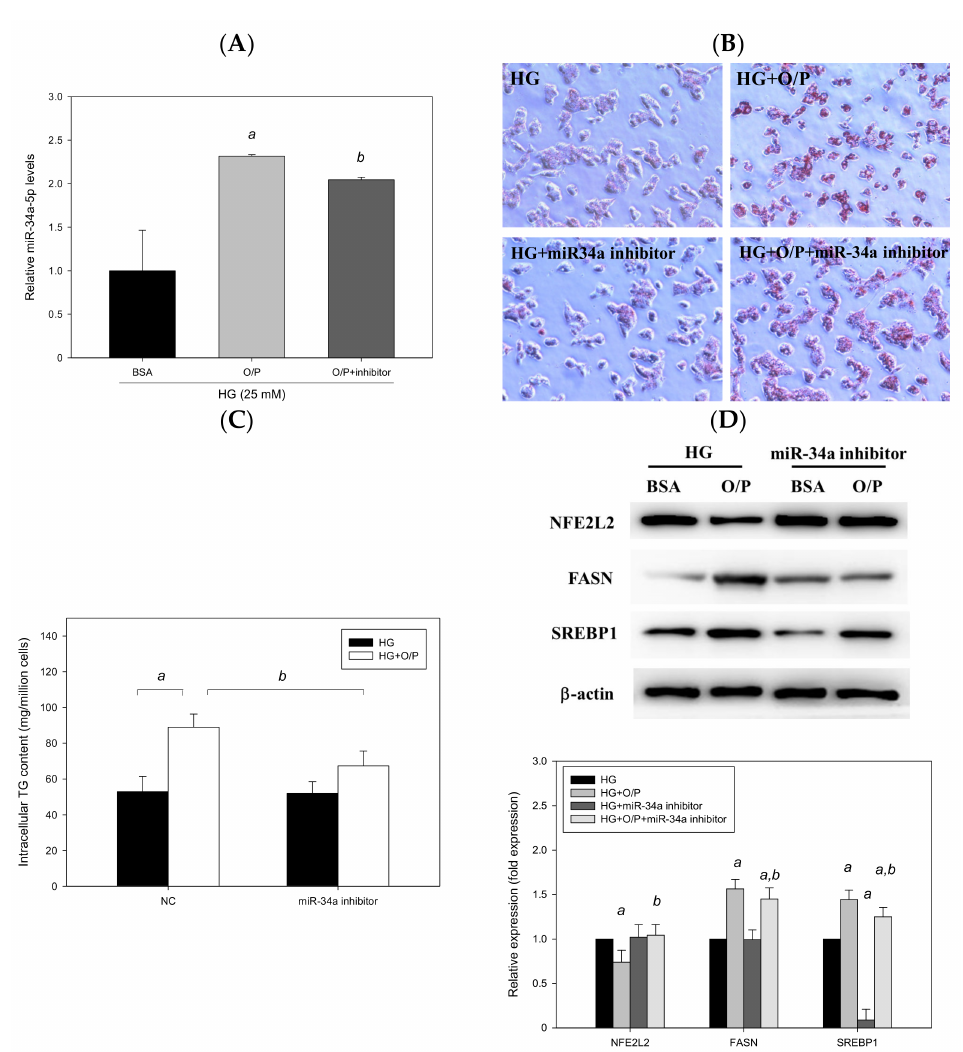
Figure 9. Suppression of miR-34a-5p expression ameliorated oleic acid/palmitic acid mixture-induced lipid accumulation in HG-treated HepG2 cells. A–D, HepG2 cells were transfected with an miR-34a- 5p inhibitor or NC for 48 h in the presence of oleic acid/palmitic acid. ( A ) Real-time PCR analysis of miR-34a-5p expression. ( B ) Oil Red O staining. ( C ) Intracellular triglyceride level. ( D ) Western blotting analysis of NFE2L2, FASN and SREBP1. a, p < 0.05 compared with the HG control group. b, p < 0.05 compared with the HG + O/P